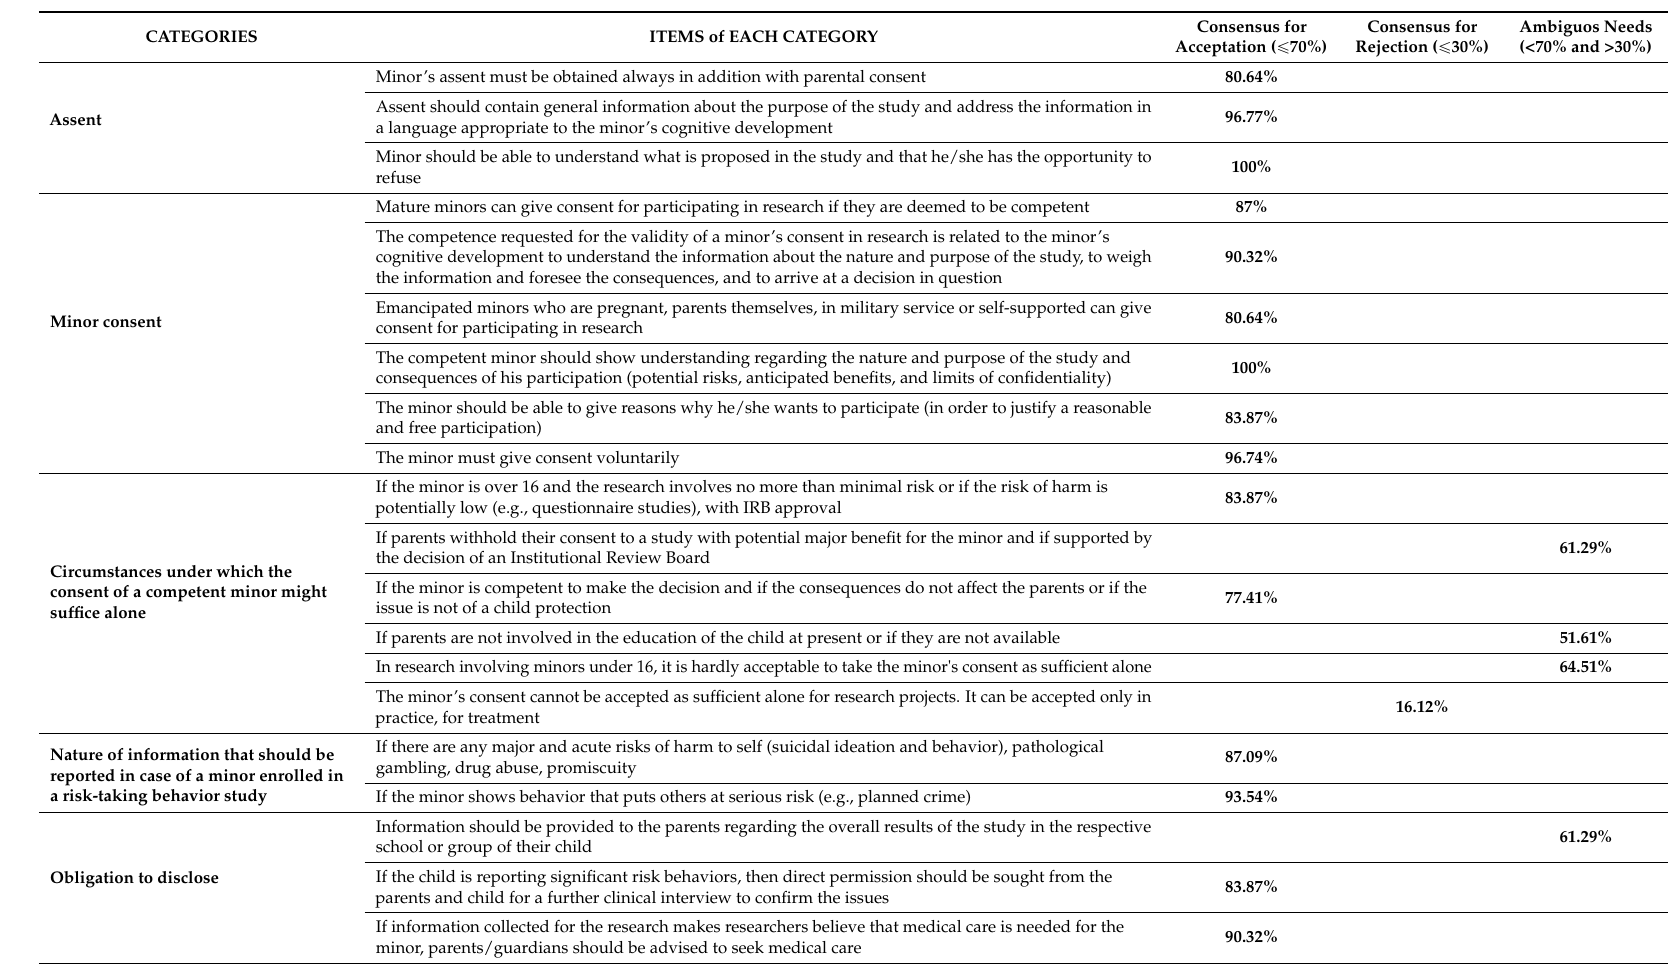
Table A1. List of Ethical Issue